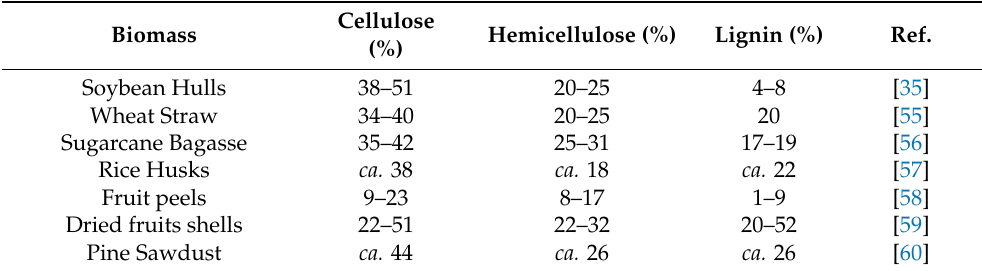
Table 2. Cellulose, hemicellulose and lignin percentages in different lignocellulosic